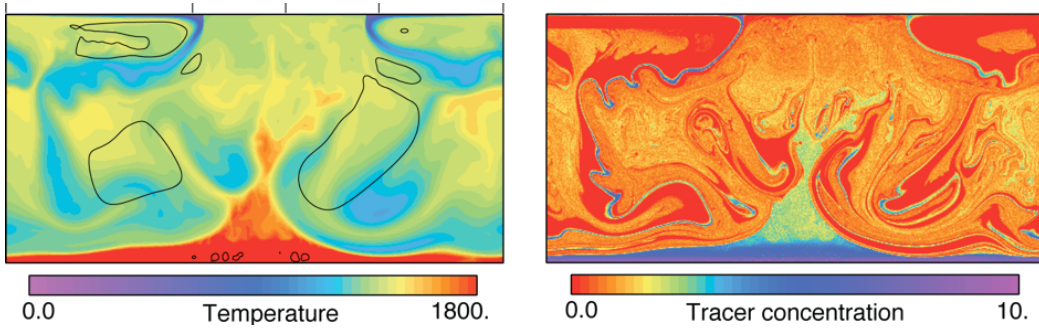
Fig. 4. Temperature and streamlines (left) and tracer concentrations (right) from a numerical model with tracers that represent subducted basaltic crust that is denser than average mantle by 150kgm − 3 . A tracer concentration of 1 corresponds to the average basaltic content of the mantle. Red zones at the top are melted zones from which tracers have been removed to the oceanic crust. From Davies (2008): Case 1 after 2000Myr. Copyright Elsevier Science. Reprinted with